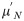
The effects of flow rate and blood rheology on the proximal and distal recirculation lengths.a) Increases in bulk flow rate were found to cause reductions in the proximal recirculation length and increases in the distal recirculation length produced by each rheological model. b) The relationship between recirculation length and normalised mean viscosity, which measures the ratio of the average apparent viscosity in a recirculation zone and the Newtonian model’s dynamic viscosity (μ′N = 0.00345Pa·s), was found to closely approximate linearity at each inlet flow rate. Furthermore, increases in normalised mean viscosity were found to cause reductions in recirculation length at each flow rate.